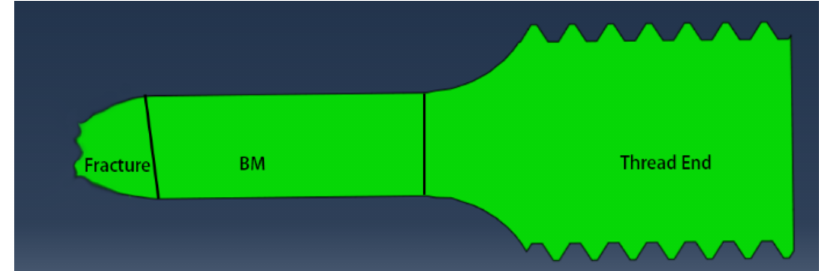
Figure 2. Schematic diagram of fracture section with fracture zone, BM zone and thread end